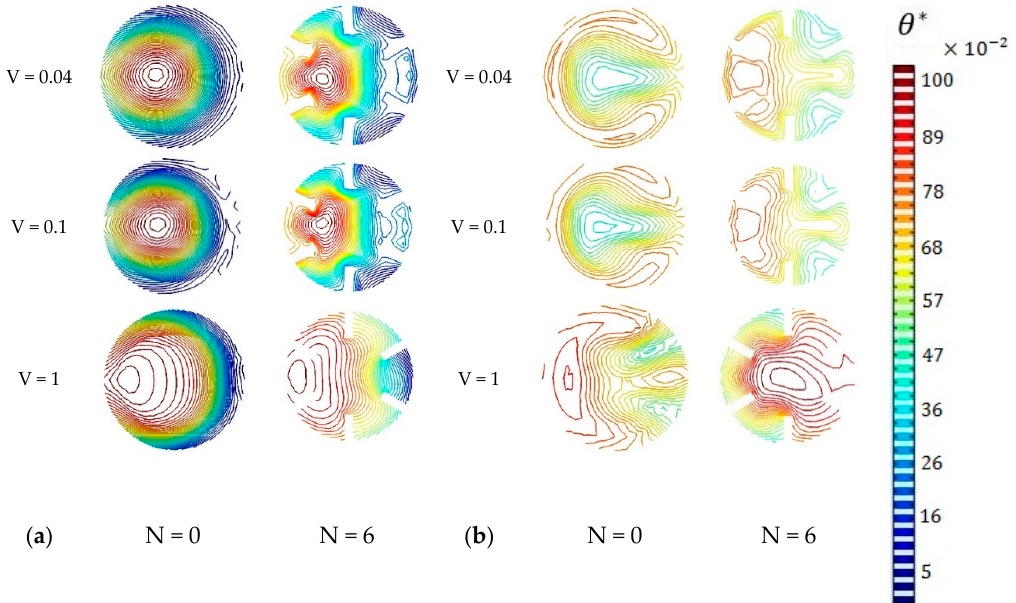
Figure 11. Temperature contours for smooth ( left ) and finned U-tube ( right ) at different velocities; ( a ) inlet pipe; ( b ) outlet pipe.